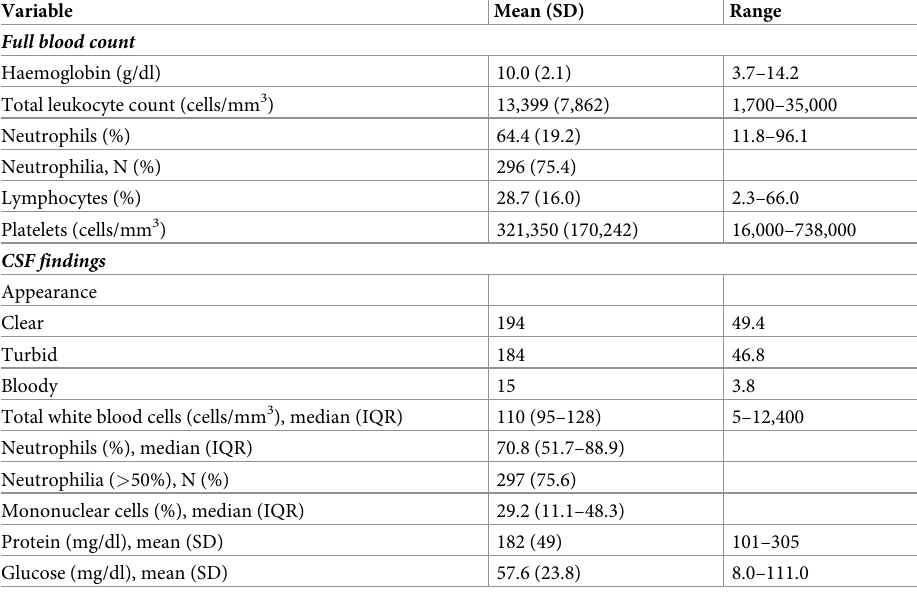
Table 3. Full blood count and CSF findings in 393 ABM children.